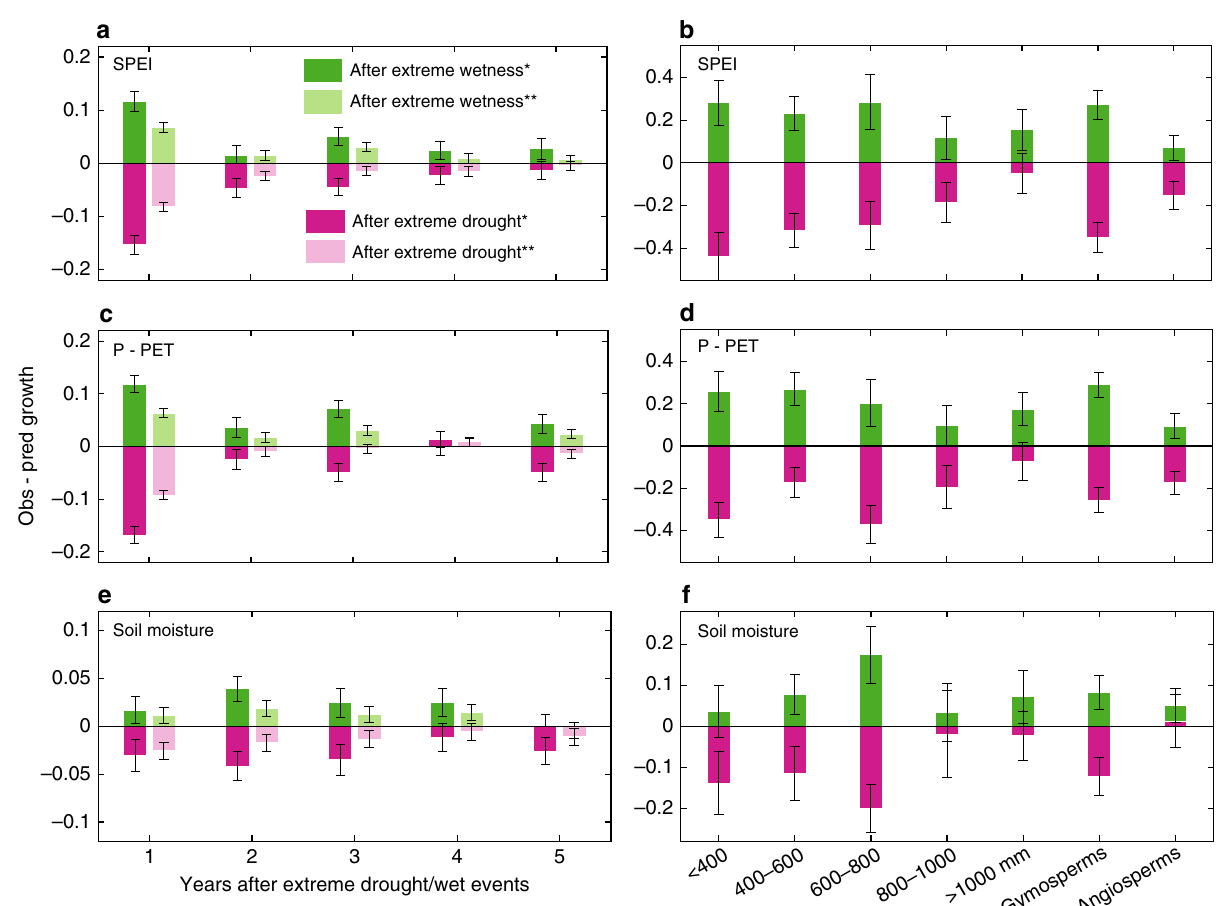
Fig. 1 Substantial enhanced radial growth after extreme wetness. Enhanced/reduced growth (unitless) after extreme wet/drought years was observed across 1929 tree-ring chronologies using the SPEI a , P − PET c , and soil moisture (for the 0 – 100 cm soil depth) e . Enhanced growth across sites that were signi fi cantly correlated with climate indices were reclassi fi ed into different mean annual precipitation bins and gymnosperm and angiosperm forest types b , d , f . Error bars represent the 95% con fi dence interval around the mean from bootstrapping ( n = 5000 resamplings). *: tree-ring sites that were signi fi cantly correlated with climate indices ( n = 631,612,773 for the SPEI, P − PET, and soil moisture, respectively) **: all tree-ring sites ( n = 1929). P − PET: precipitation minus potential evapotranspiration, SSPEI: Standardized Precipitation-Evapotranspiration